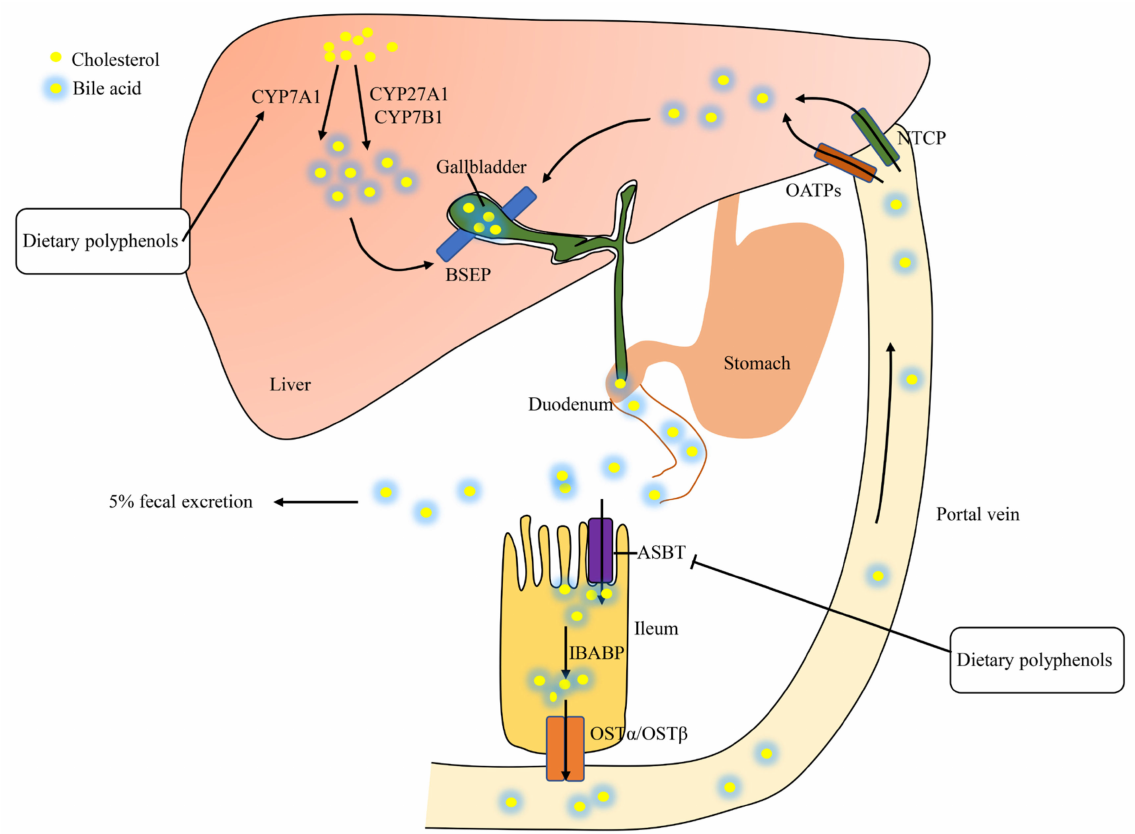
Figure 5. Enterohepatic circulation of bile acids. CYP7A1. cholesterol 7 α -hydroxylase; CYP27A1, sterol 27-hydroxylase; CYP7B1, oxysterol 7 α -hydroxylase; BSEP, bile salt export pump; OATPs, organic anion transporting polypeptides; NTCP, sodium-dependent taurocholate co-transporting peptide; ASBT, apical sodium-dependent bile acid transporter; IBABP, ileal bile acid binding protein; OST α /OST β , organic solute transporters alpha and